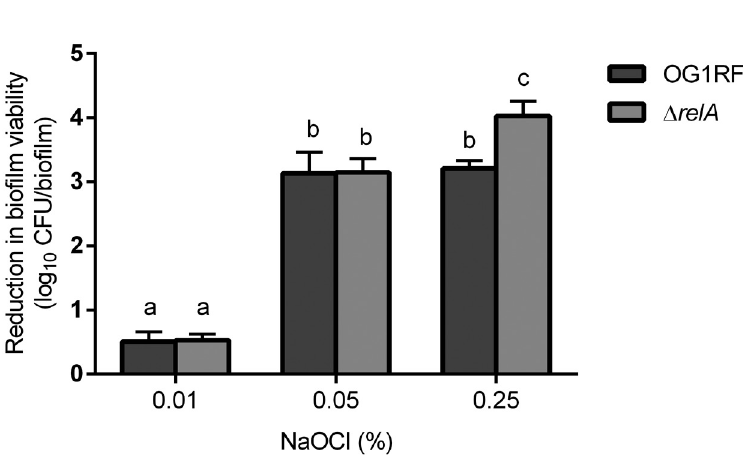
Figure 3- Treatment efficacy of NaOCl on E. faecalis biofilms. The 48-h E. faecalis OG1RF (dark gray bar) and Δ relA (gray bar) biofilms were treated by NaOCl. The efficacy of each treatment is presented as the reduction in biofilm viability. Different lowercase letters indicate significant difference (p<0.05)